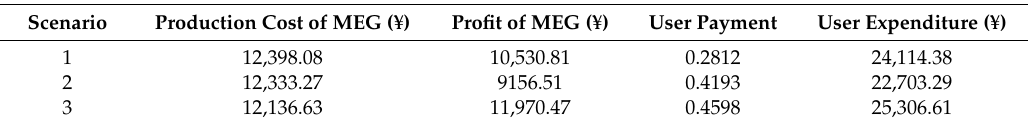
Table 3. The economic in different